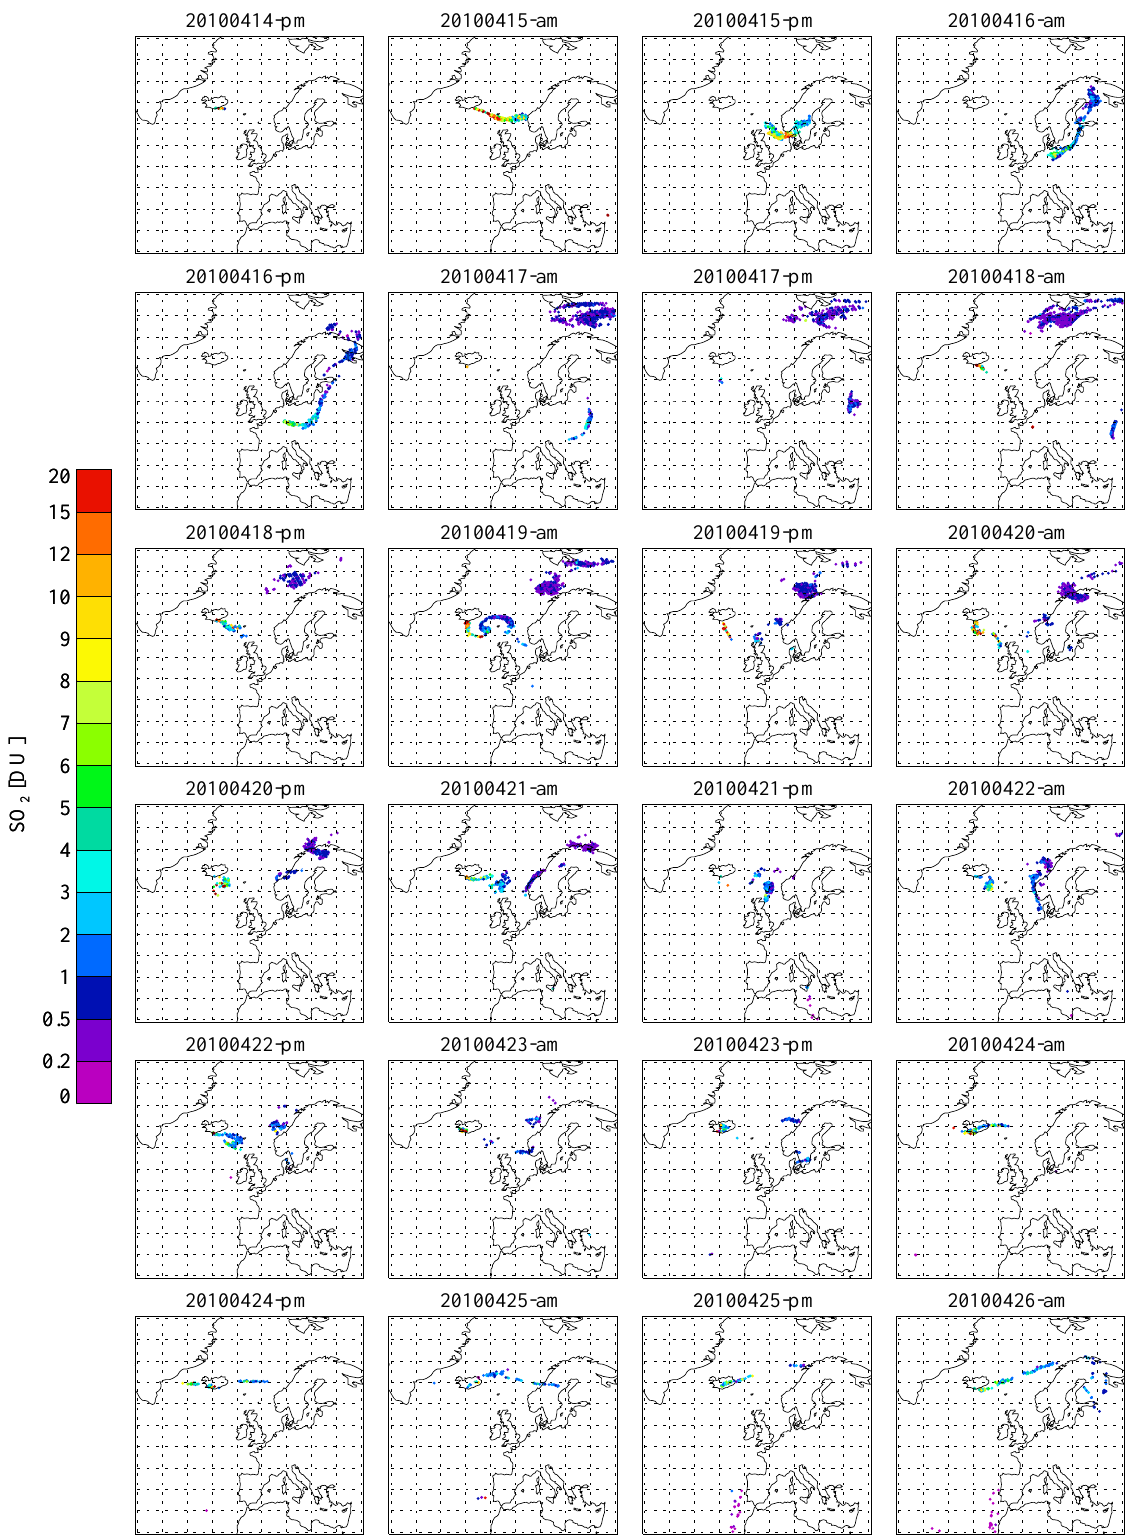
Fig. 7. IASI SO 2 column amount, divided into morning and afternoon orbits, for the period from 14 to 26 April 2010.